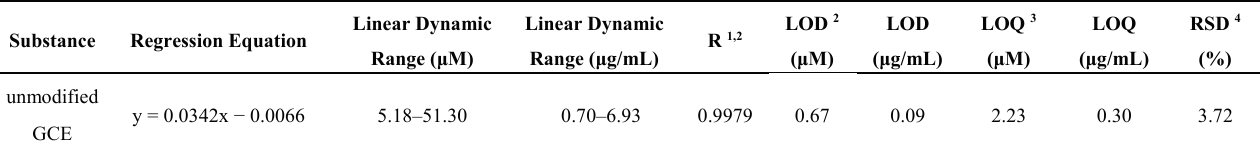
Table 3. Analytical parameters of electrochemical detection of unmodified GCE, n = 3.